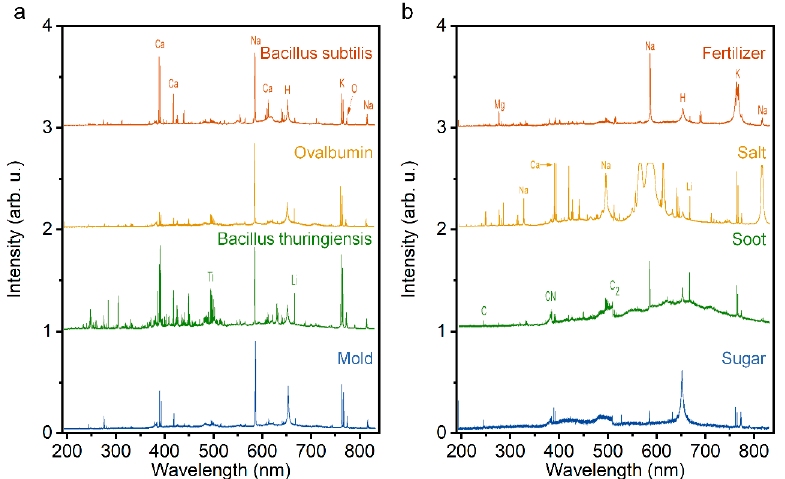
Figure 19. LIBS spectra of biological warfare agent surrogates ( a ) and non-biological interferents ( b ), including fertilizer, iodized salt, diesel particulate (soot), and granulated sugar [302].